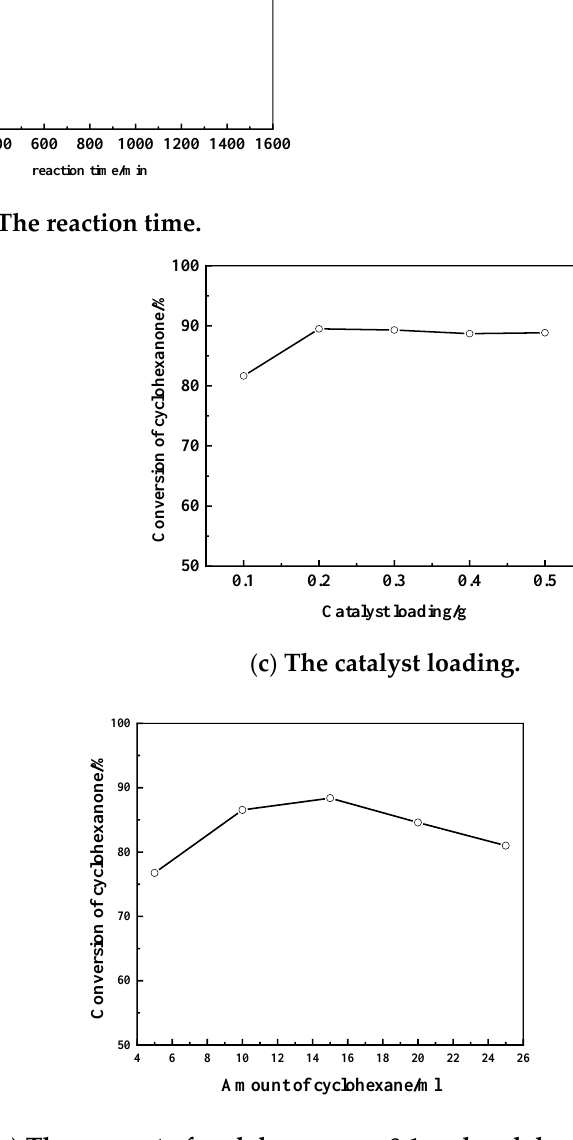
( e ) The amount of cyclohexane per 0.1 mol cyclohexanone. Figure 14. Effects of reaction conditions on conversion of cyclohexanone. The reaction conditions are: ( a ) 0.2 g loading, 95 °C, 15 mL cyclohexane/0.1 mol cyclohexanone, 3.0:1.0 molar ratio of glycerol to cyclohexanone; ( b ) 0.2 g loading, 95 °C, 90 min, 10 mL cyclohexane/0.1 mol cyclohexanone; ( c ) 95 °C, 90 min, 15 mL cyclohexane/0.1 mol cyclohexanone,3.0:1.0 molar ratio of glycerol to cyclohexanone; ( d ) 0.2 g loading, 90 min, 15 mL cyclohexane/0.1 mol cyclohexanone, 3.0:1.0 molar ratio of glycerol to cyclohexanone; ( e ) 0.2 g loading, 95 °C, 90 min, 3.0:1.0 molar ratio of glycerol to cyclohexanone.